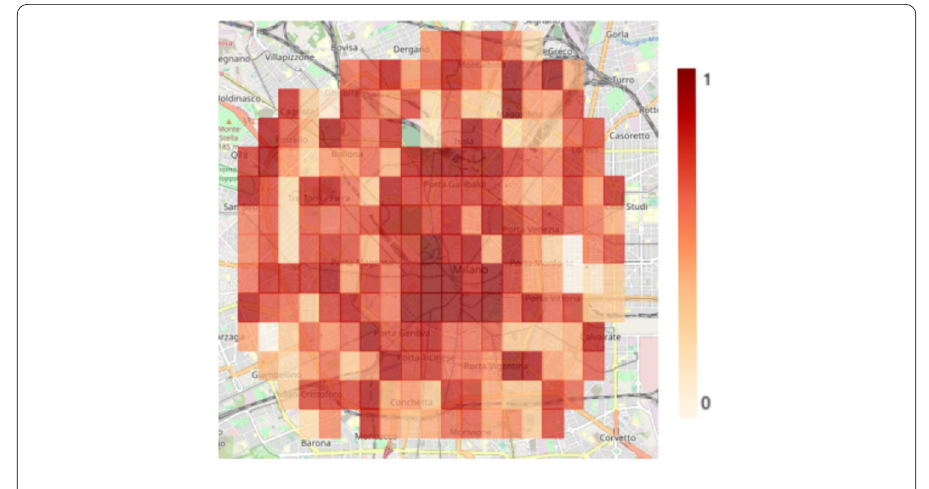
Figure 4 Walkability index in Milan